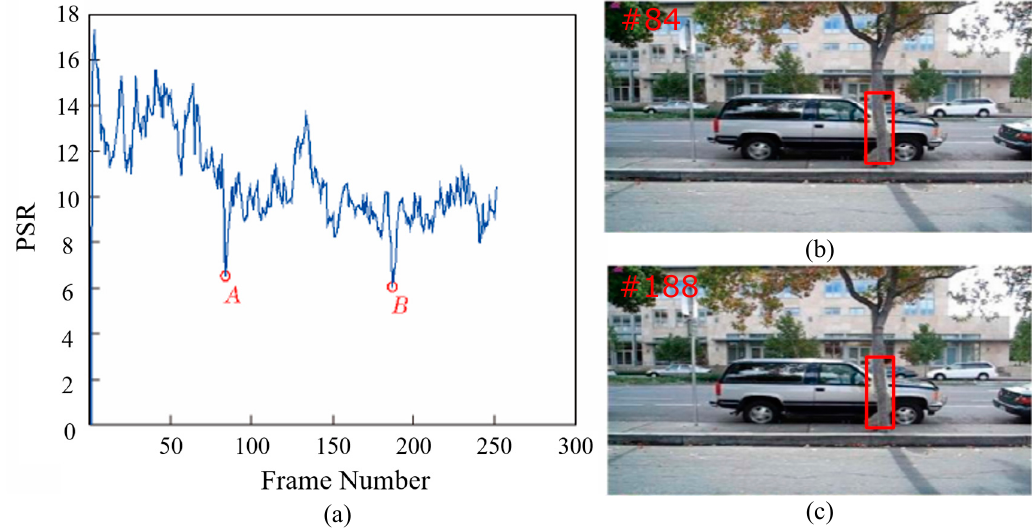
Figure 4. Analysis and ( a ) distribution of the peak-to-sidelobe ratio (PSR) on the David3 dataset: ( b ) 84th and ( c ) 188th frame of the David3 dataset.